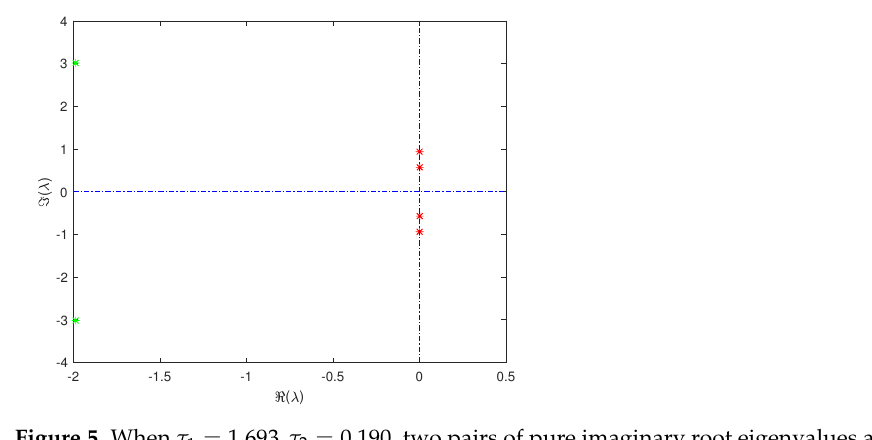
Figure 5. When τ 1 = 1.693, τ 2 = 0.190, two pairs of pure imaginary root eigenvalues at the double Hopf